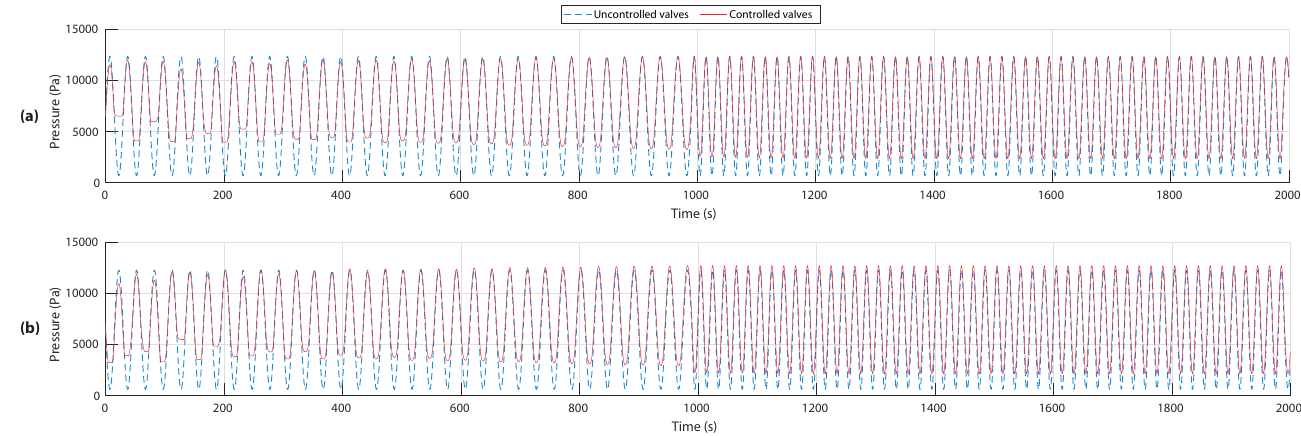
Figure 8. Obtained pressure in the OWCs without and with airflow control. ( a ) Airflow in OWC1. ( b ) Airflow in OWC2.